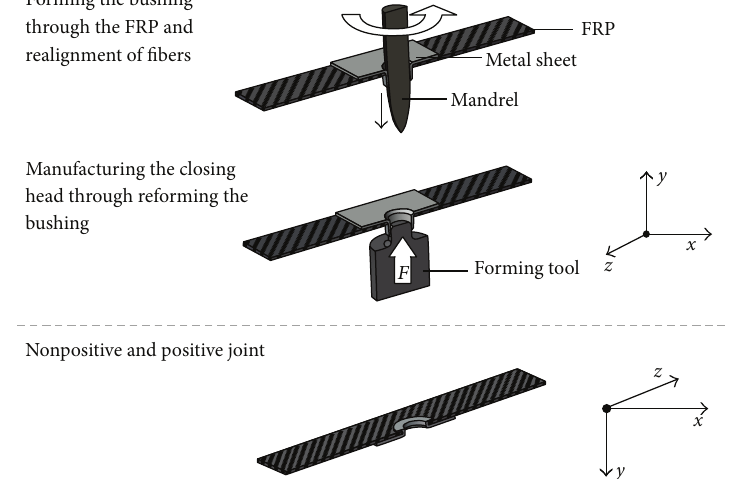
Figure 3: Principle of manufacturing a load adjusted metal/FRP